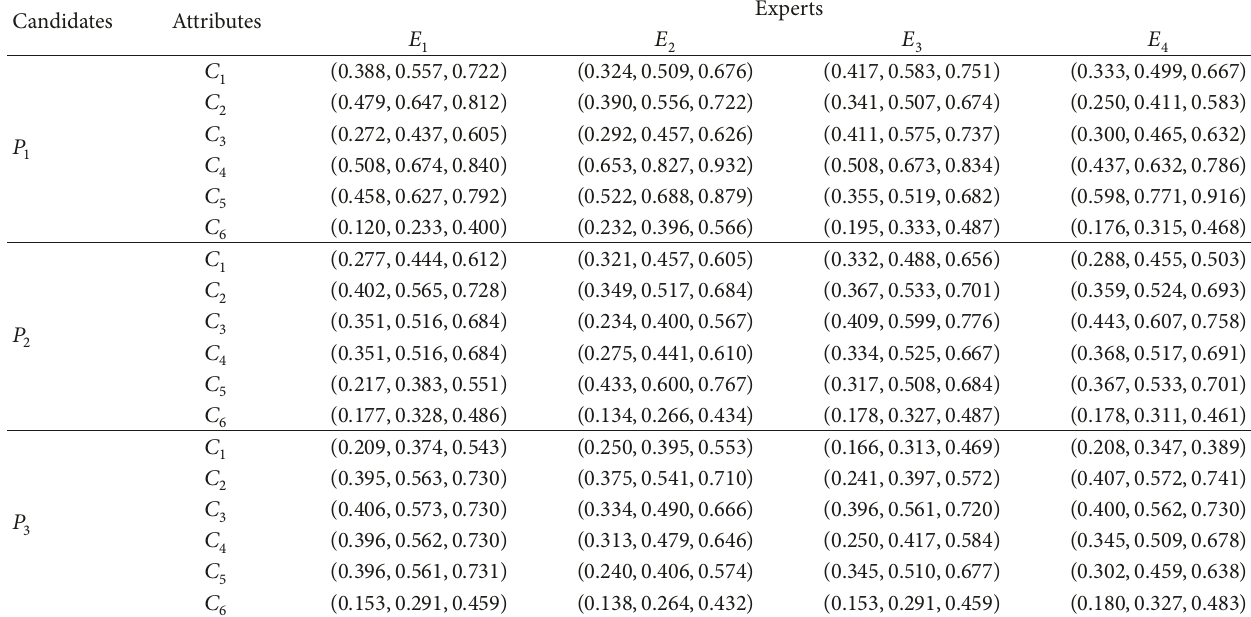
Table 6: Evaluation on cooperation attributes of candidates given by